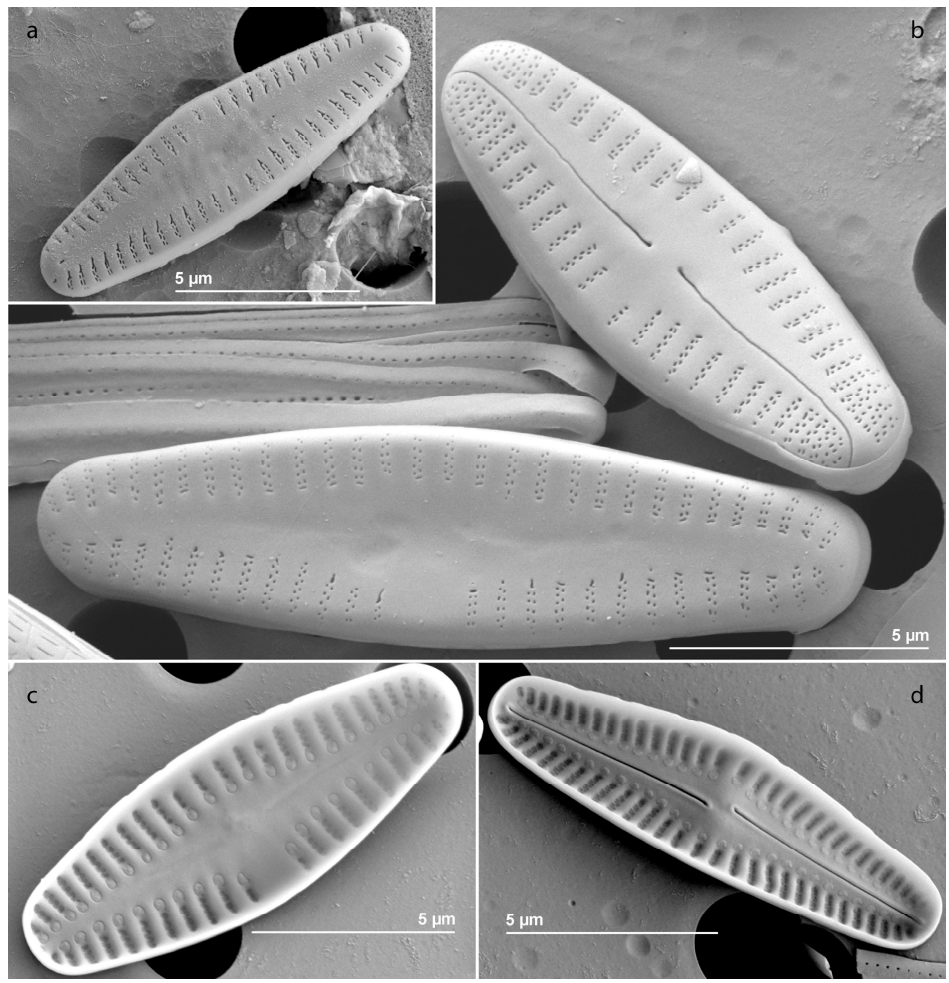
Figure 6. Scanning Electron Microscopy illustrations of some individuals observed in the studied springs. Crenotia angustior ( a ). Crenotia thermalis ( b – d ). The eigenvalues of the first CCA axis (0.257) and the second CCA axis (0.114) were both significant ( p = 0.01 with Monte Carlo permutations test with 999 permutations), and the to- tal explained variance in the species data was 18.5% (Figure 10). The diatom–environment correlations (Pearson) for CCA axis-1 (0.875) and CCA axis-2 (0.681) were high, indicating a relatively strong relationship between diatom species and measured environmental vari- ables. Pinnularia kuetzingii , Fragilaria famelica , and Navicula veneta were associated with the highest values of pH, conductivity, and TDS, and also with the highest concentrations in lithium, potassium, chloride, and bromine ion concentrations. Crenotia angustior ,